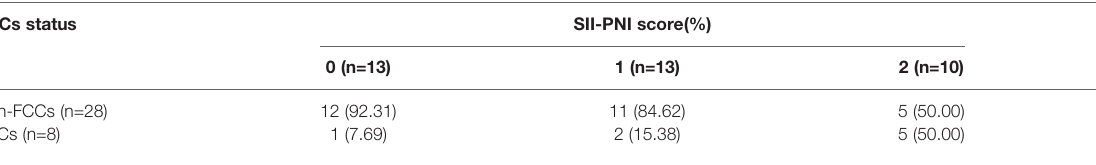
TABLE 3 | Relationship between FCCs status and the SII-PNI score.